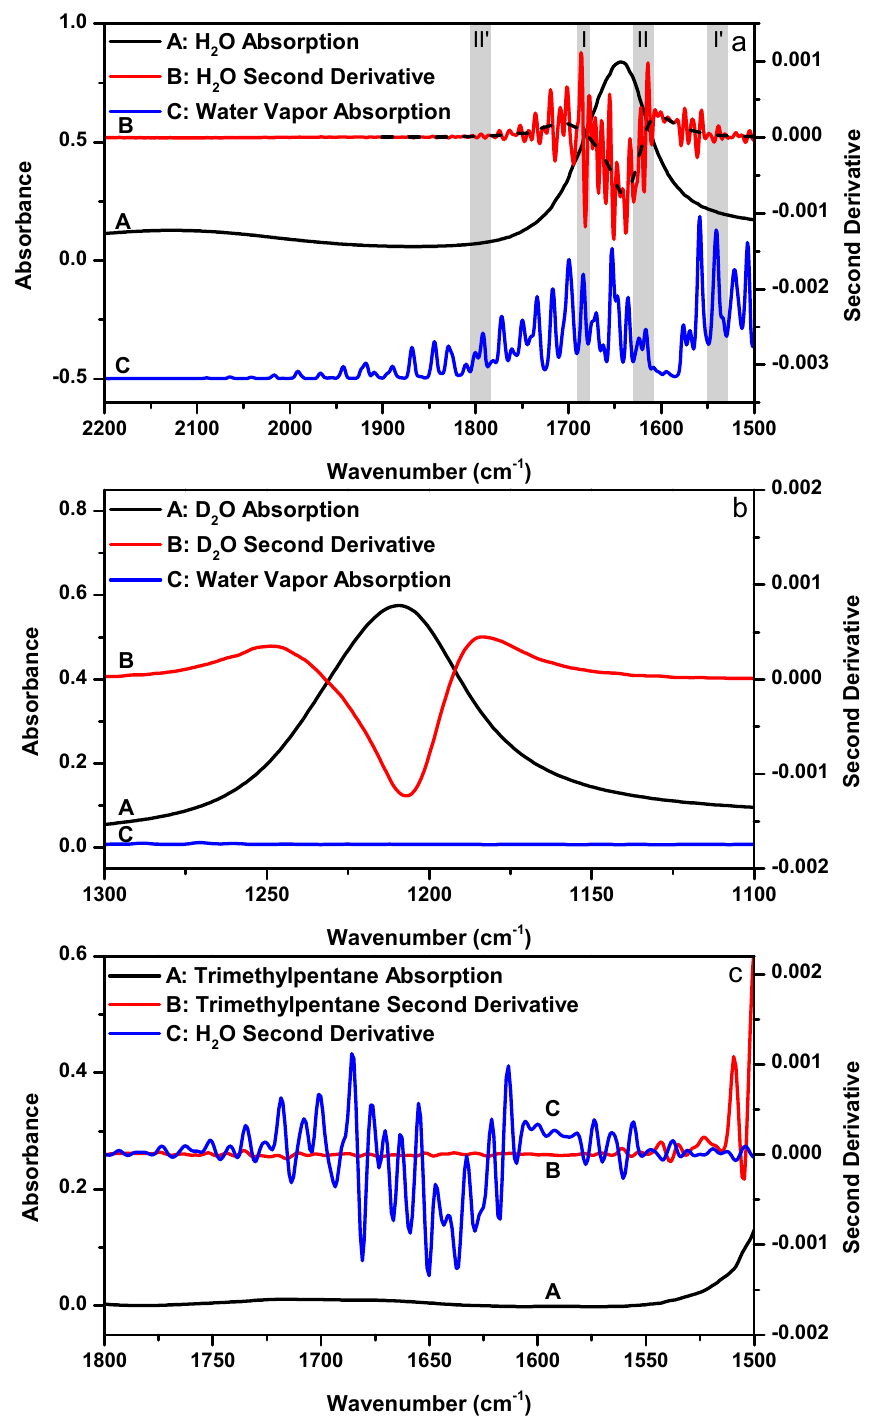
Figure 1. ( a ) FTIR absorption (A: black) and second derivative (B: red) spectra of liquid H O and the absorption spectrum of water vapor (C: blue). Dashed line: theoretical second 2 derivative spectrum of liquid H O; ( b ) FTIR absorption (A: black) and second derivative 2 (B: red) spectra of liquid D O and the absorption spectrum of water vapor (C: blue); 2 ( c ) FTIR absorption (A: black) and second derivative (B: red) spectra of trimethylpentane and the second derivative spectrum of liquid H O (C: blue). Second derivative spectrum is 2 displayed with its resolved peaks pointing downwards. The absorbance of water vapor is in arbitrary unit. Spectral resolution: 4 cm − 1